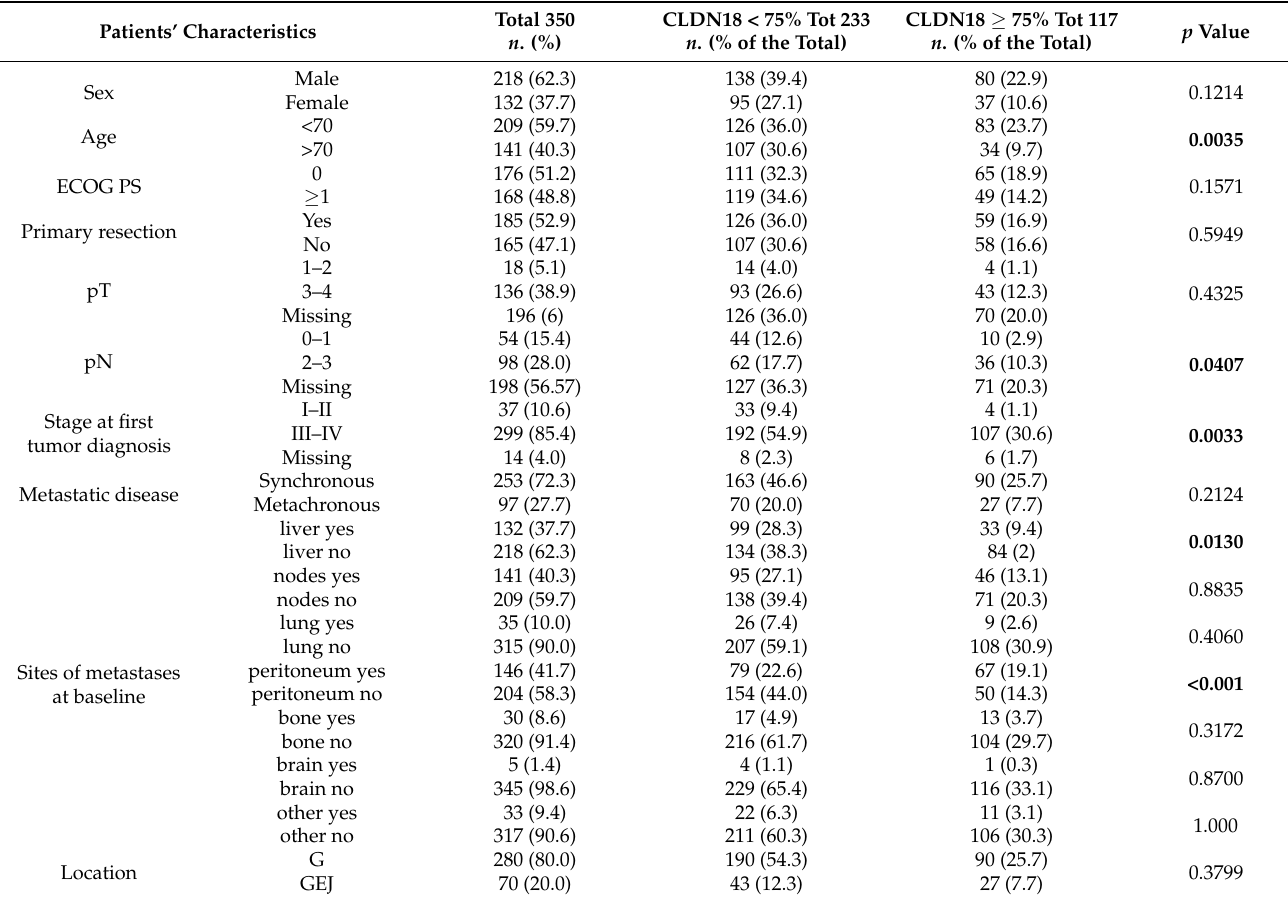
Table 1. Clinicopathological features of the considered series according to CLDN18 status (note that the sum of patients does not add to 350 patients for all the parameters due to missing clinical data or exhausting tumor tissue). Total 350 Patients’ Characteristics n .